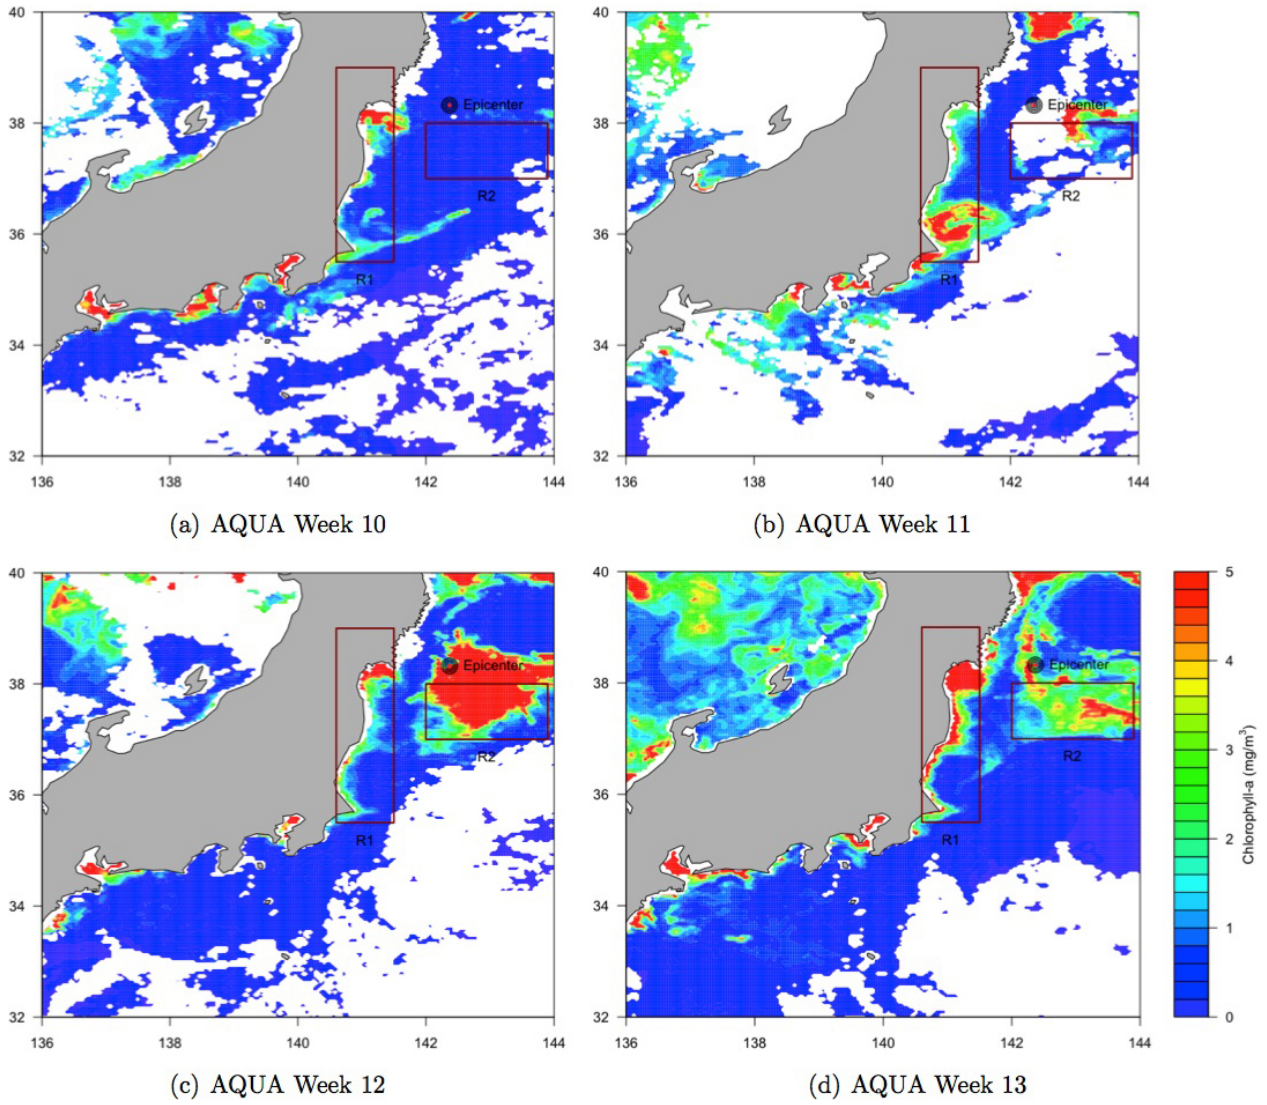
Figure 4. Chlorophyll concentration for the 4 weeks after the tsunami using AQUA. The vertical axis indicates latitude degrees north, and the horizontal axis indicates longitude degrees